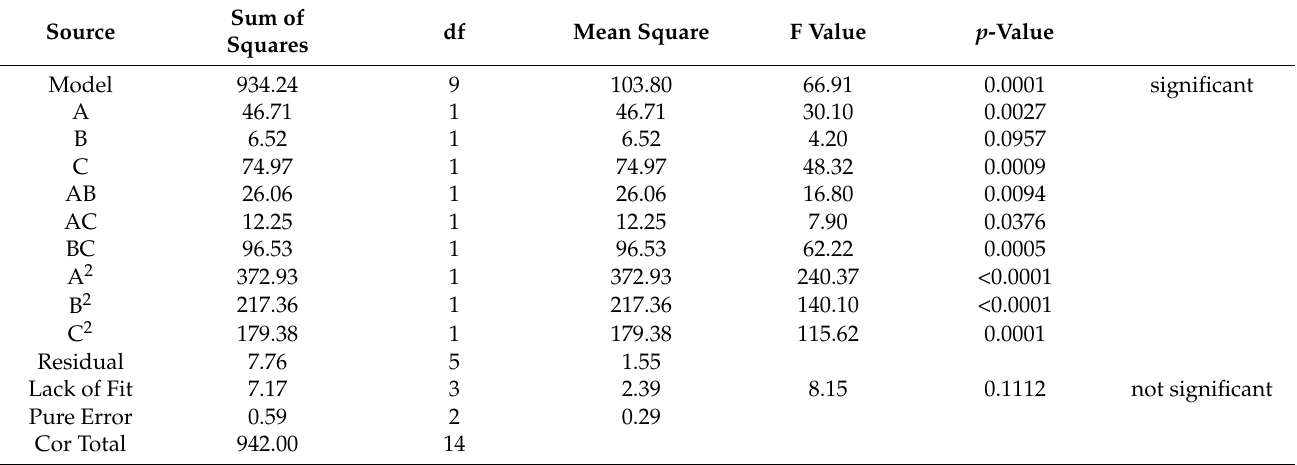
Table 10. ANOVA for response surface quadratic